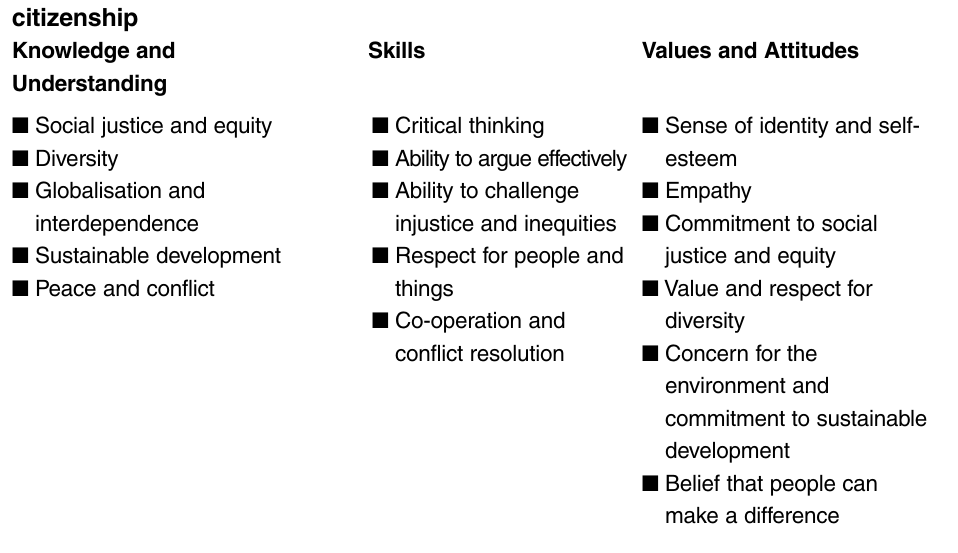
Table 1: Oxfam’s perspective of key elements for responsible